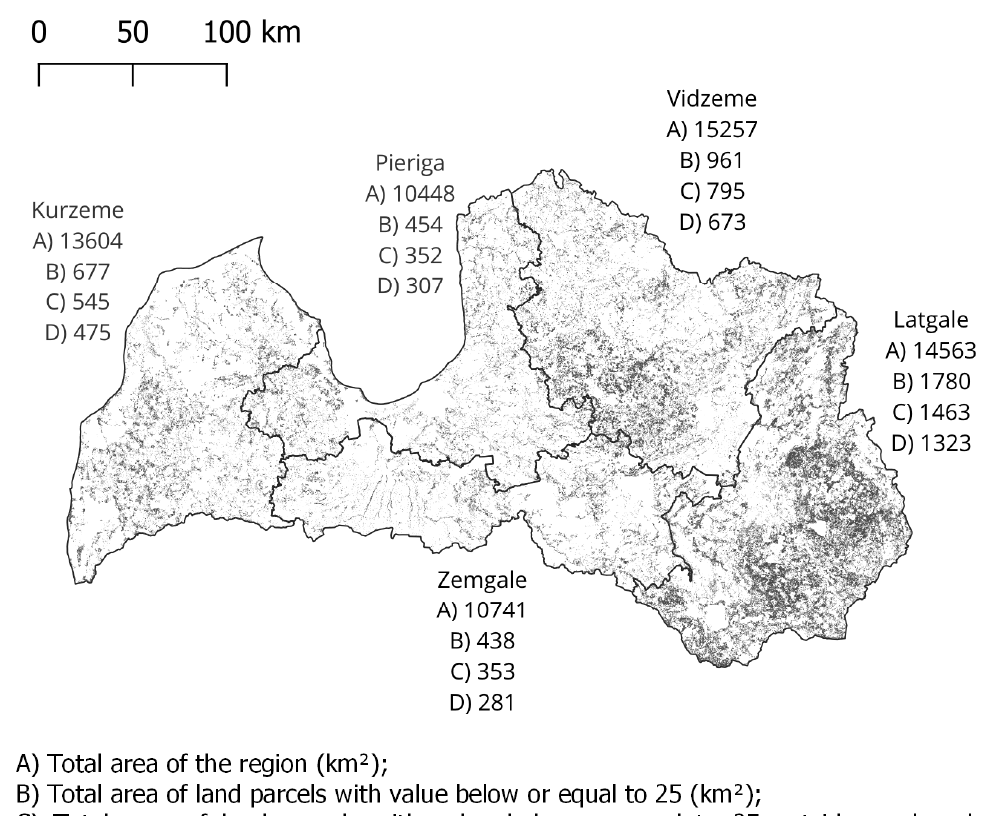
Figure 3. Distribution of agricultural land parcels where agroforestry could provide a solution for more effective land management across different statistical regions of Latvia (Kurzeme, Pieriga, Zemgale, Vidzeme, and Latgale). Gray areas on the map of Latvia correspond to the D (total area of agricultural land parcels with land ‐ quality value ≤ 25 points outside the road and watercourse buffers and without underground drainage systems).